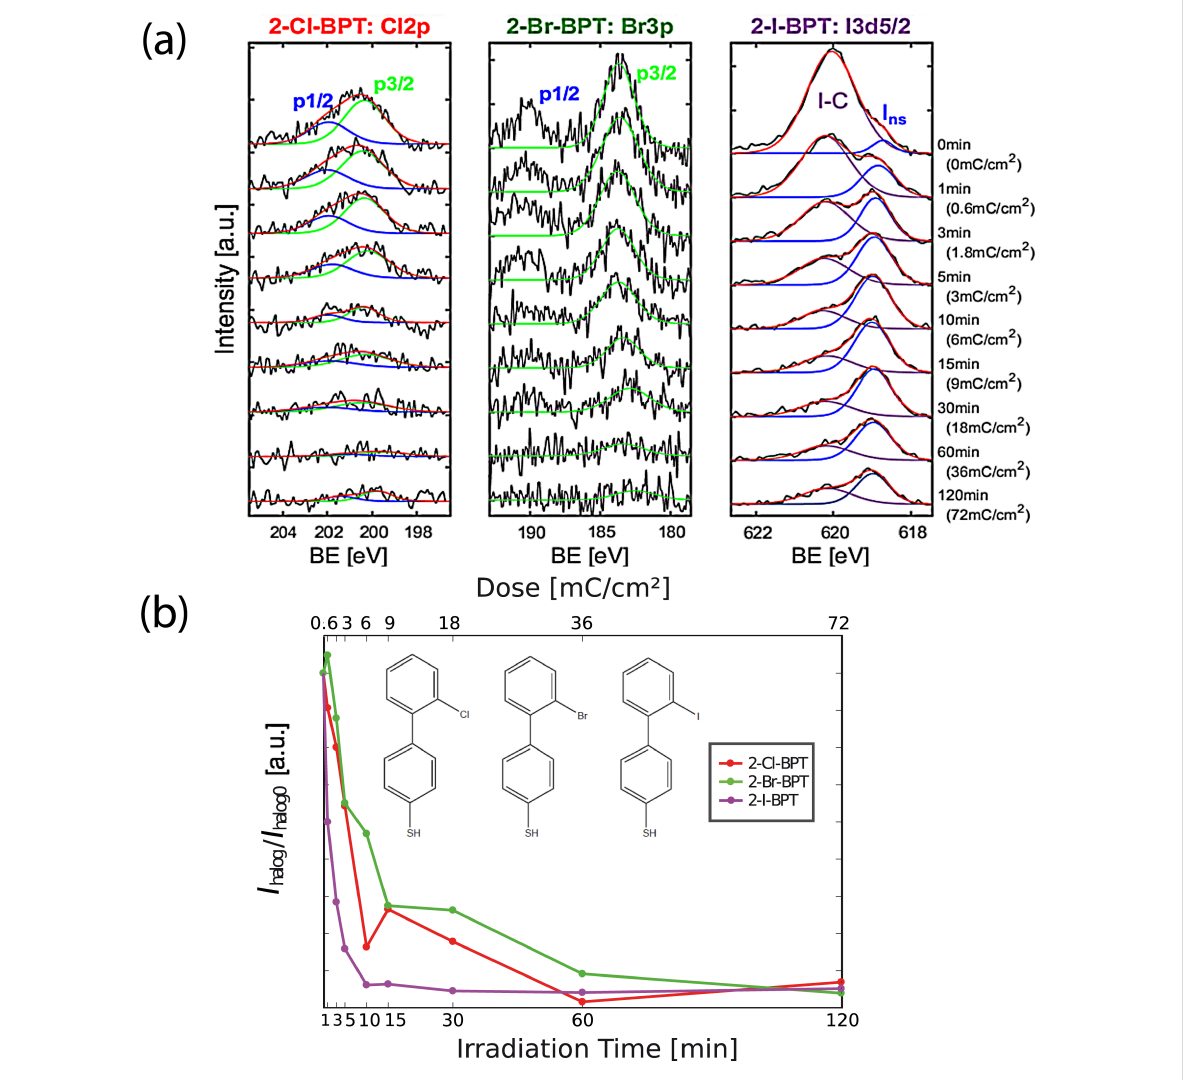
Figure 2: XP spectra of the Cl 2p, Br 3p doublets and the I 3d 5/2 peak regions of SAMs made of 2-Cl-BPT 2-Br-BPT and 2-I-BPT after 0 to 120 min of electron irradiation respectively, where 1 min corresponds to an electron dose of 0.6 mC/cm 2 . (a) Raw and fitted spectra of the Cl 2p, Br 3p doublets (blue fit: p 1/2 ; green fit: p 3/2 ) and the I 3d 5/2 peak of the I 3d doublet peaks of the three halogenated BPT molecules, as a function of electron dose. After electron irradiation, besides the iodine–carbon signal (I–C), a new iodine species becomes more dominant ( I nS ). (b) Evolution of halogen peak area I halog for Cl (red), Br (green) and I (purple) normalized to the non-irradiated halogen peak area I halog0 due to increasing irradiation